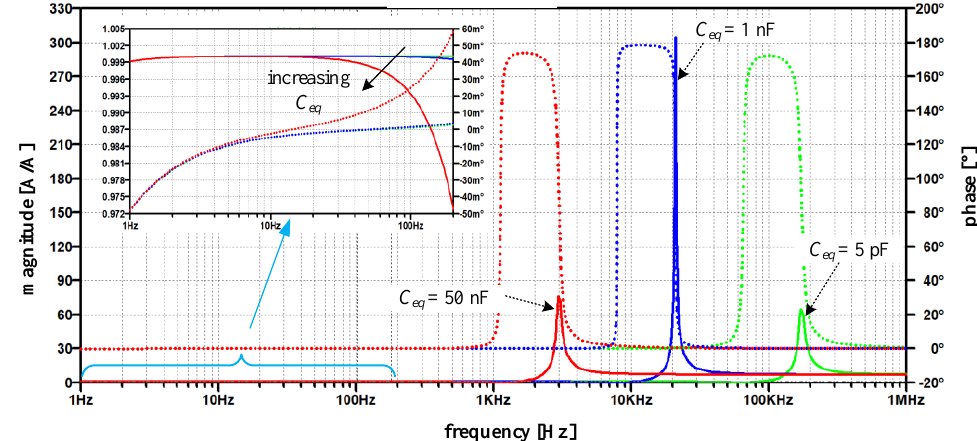
Figure 7. Magnitude and phase of the current ratio H I — original circuit (magnitude-solid line, phase — dotted line); for varying C eq = {5 pF, 1 nF, 50 nF} with detailed H I between 1 Hz and 200 Hz.